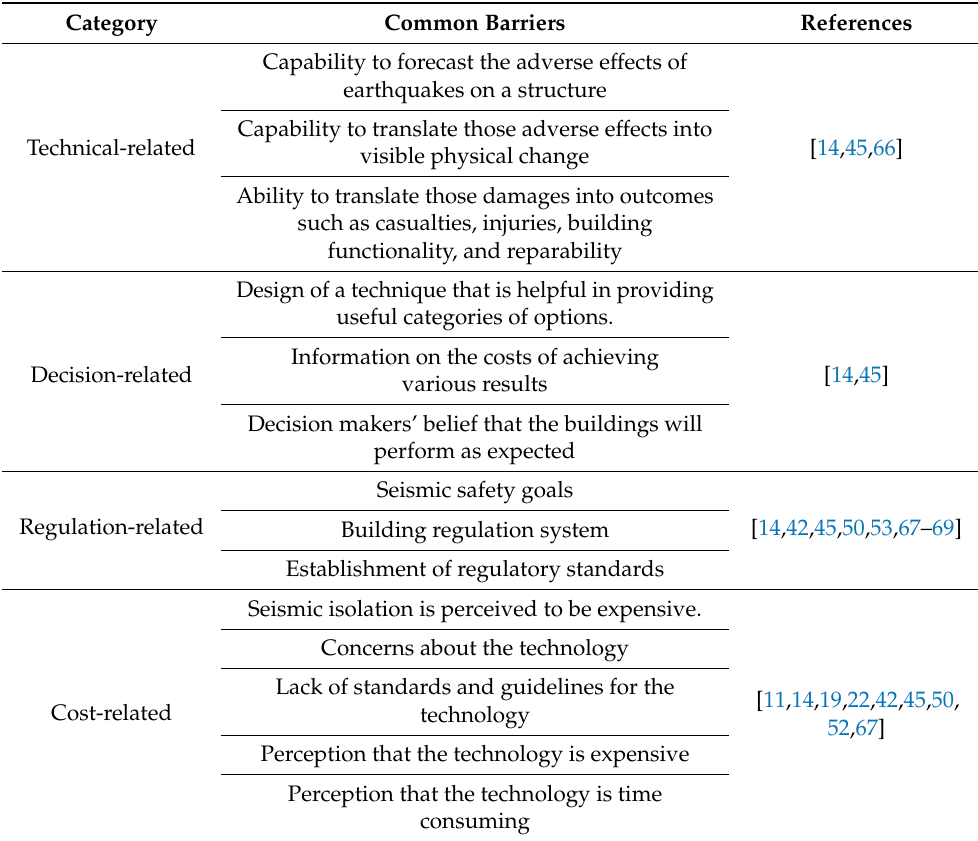
Table 2. Barriers to the adoption of